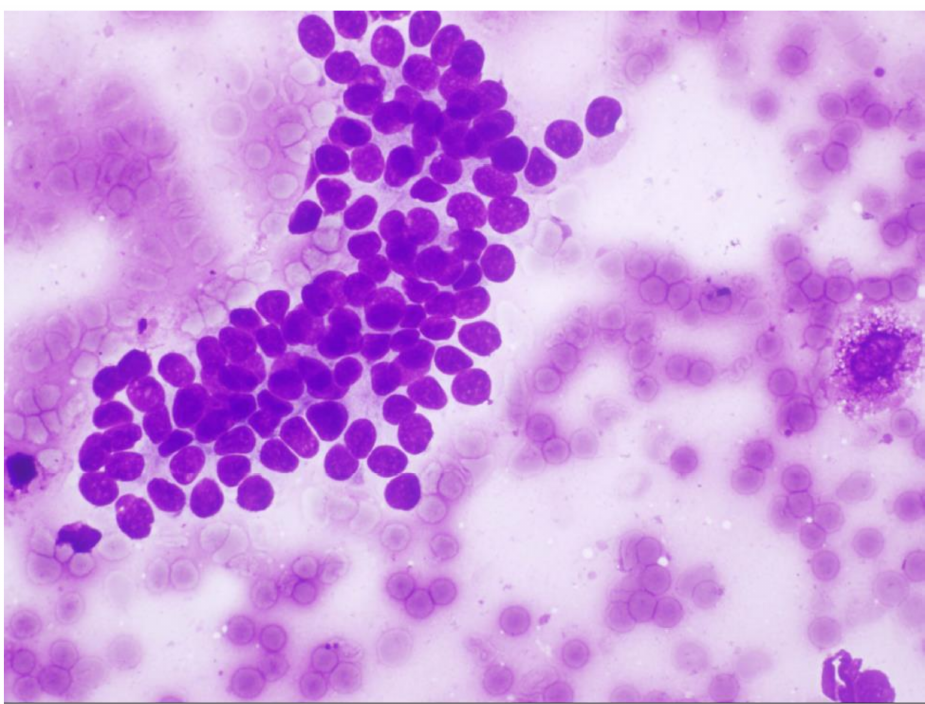
Figure 3. Sheet of ductal epithelial cells showing some loss of polarity and nuclear crowding consistent with an atypical designation (Diff